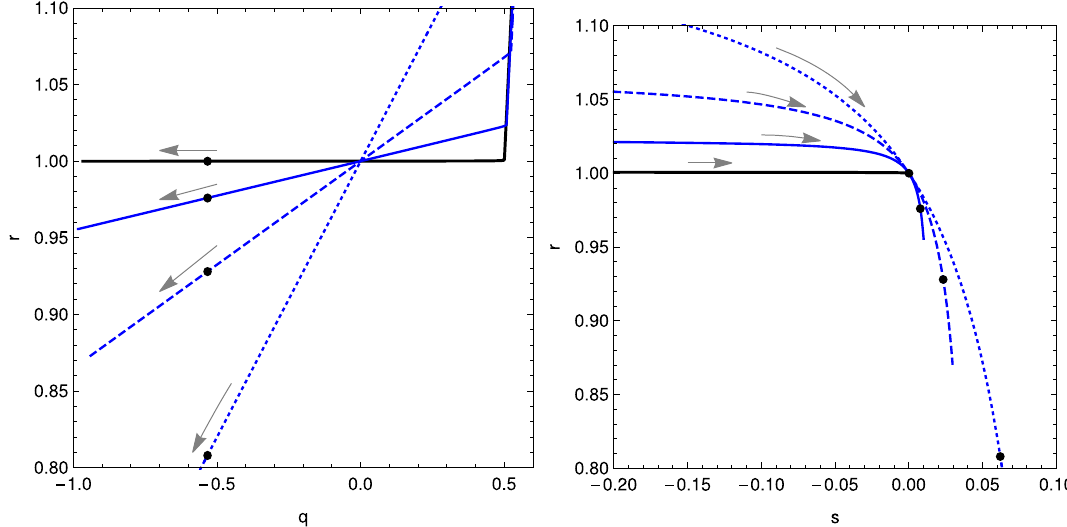
Fig. 11 The figures show the space parameter r − q (left) and r − s (right) for the Γ 1 T model and several values of the α parameter. Black dots indicate current values and gray arrows the evolution’s direction.